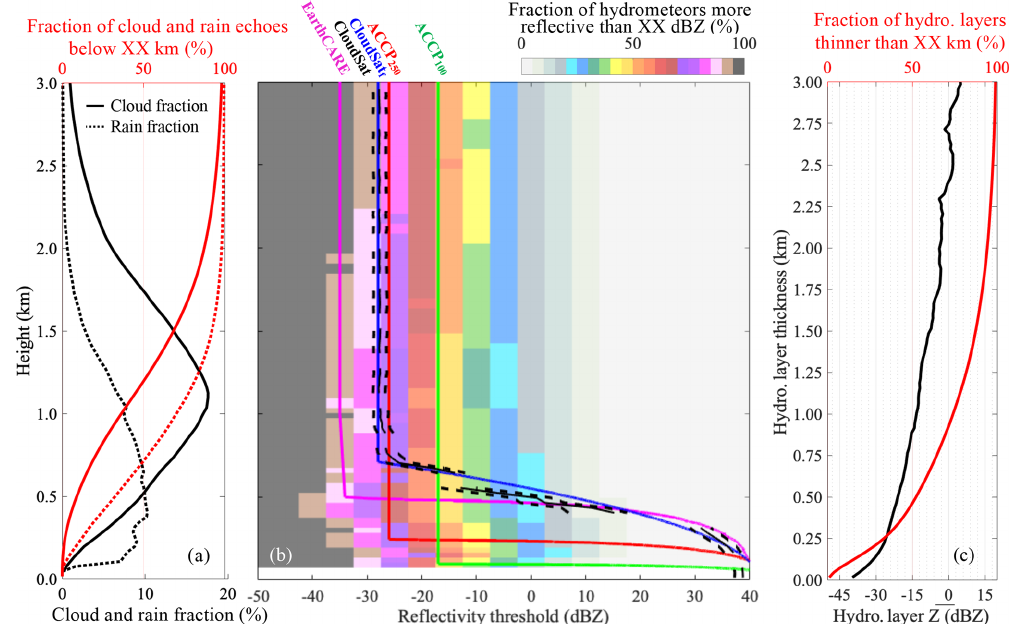
Figure 5. From ground-based KAZR observations collected between October 2015 and November 2017, (a) profile of cloud (solid black line) and sub-cloud-layer rain (dotted black line) fraction and the fraction of either cloud (solid red line) or sub-cloud-layer rain (dotted red line) echoes located below a certain height. Fractions are estimated based on the total number of observed profiles excluding those determined to contain high, deep or ice clouds. (b) Fraction of hydrometeor (cloud or rain) echoes with reflectivity larger than a given reflectivity threshold (colormap) with superimposed surface clutter profile as simulated for the CloudSat f (royal blue line), EarthCARE (magenta line), ACCP 250 (red line) and ACCP 100 (green line) CPR configurations and as observed by the CloudSat CPR between May 2010 and November 2017 (broken black line marks the median; dotted black lines mark the interquartile range). (c) Median profile of hydrometeor layer mean reflectivity as a function of thickness (black) and the fraction hydrometeor layers thinner than a certain thickness